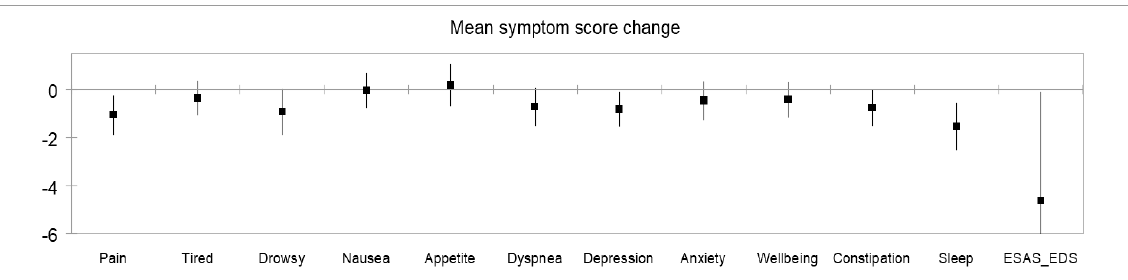
Figure 2. Mean symptom score change between the initial IAPCPC consultation and the first follow up.